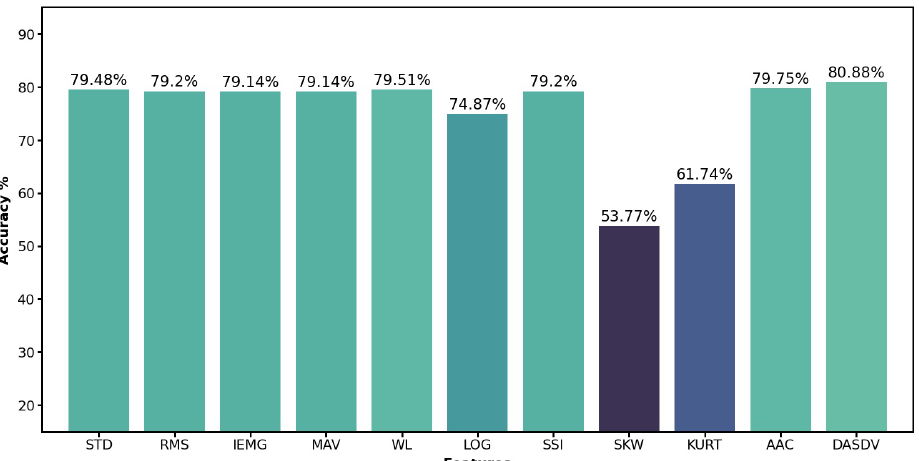
Figure 1. Single feature performance with window size 200 ms. The eleven features are Standard Deviation (STD), Root Mean Square (RMS), Integrated EMG (IEMG), Mean Absolute Value (MAV), Waveform Length (WL), Log Detector (LOG), Simple Square Integral (SSI), Skewness (SKW), Kurtosis (KURT), Average Amplitude Change (AAC) and Difference Absolute Standard Deviation Value (DASDV). The classifier used was lightGBM. The cross-validation method used was leave-one- repetition-out cross-validation which used one repetition data for testing and the rest three repetitions for training the model, and repeated this process four times to cover all repetitions for